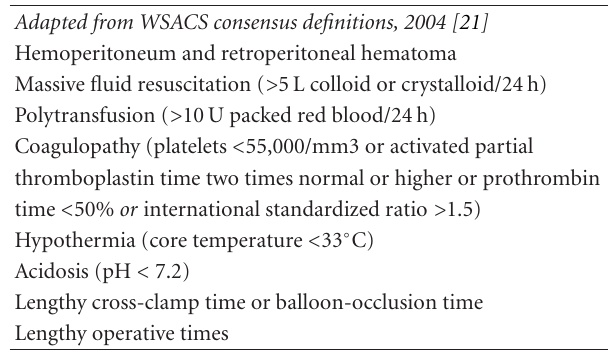
Table 2: Established risk factors for IAH/ACS in acute abdominal vascular